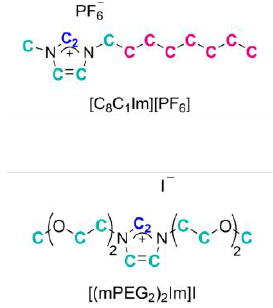
Figure 1. Structure of 1-methyl-3-octyl-imidazolium hexafluorophosphate [C 8 C 1 Im][PF 6 ] ( top ) and 1,3-bis(polyethylene glycol)imidazolium iodide [(mPEG 2 ) 2 Im]I ( bottom ). The different carbon atoms giving rise to the three discernible C 1s peaks are color-coded in blue (C 2 peak), in turquoise (C hetero ), and in pink (C alkyl ).